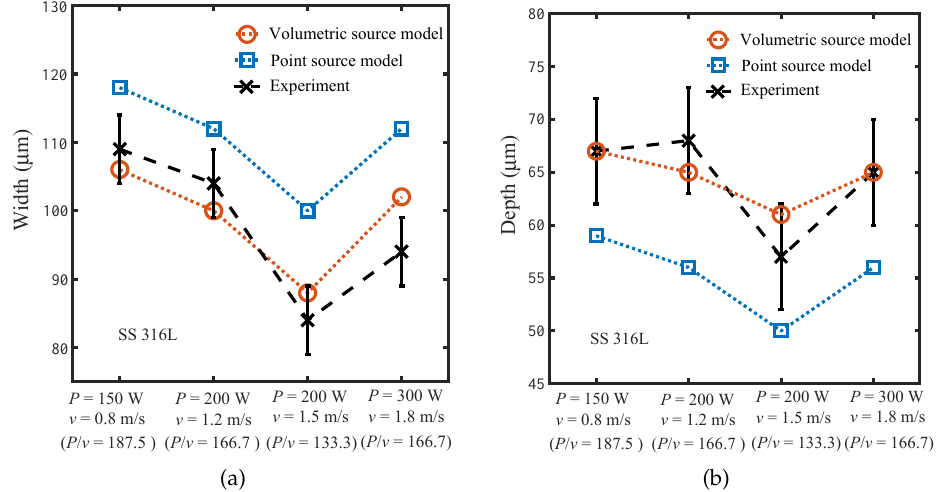
Figure 7. The predicted melt-pool ( a ) width and ( b ) depth and the experimental measurements under various laser powers and scanning